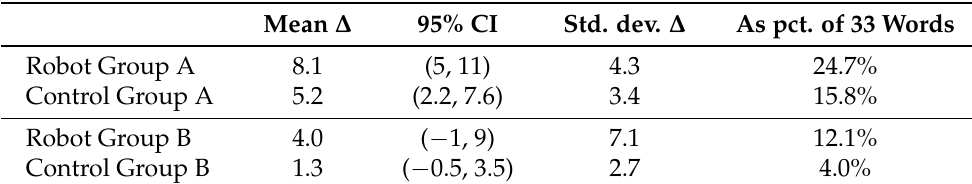
Table 4. Breakdown of vocabulary scores for day-care centers by group; the 95% confidence interval was calculated by bootstrapping. Mean ∆ 95% CI Std. dev. ∆ As pct. of 33 Words